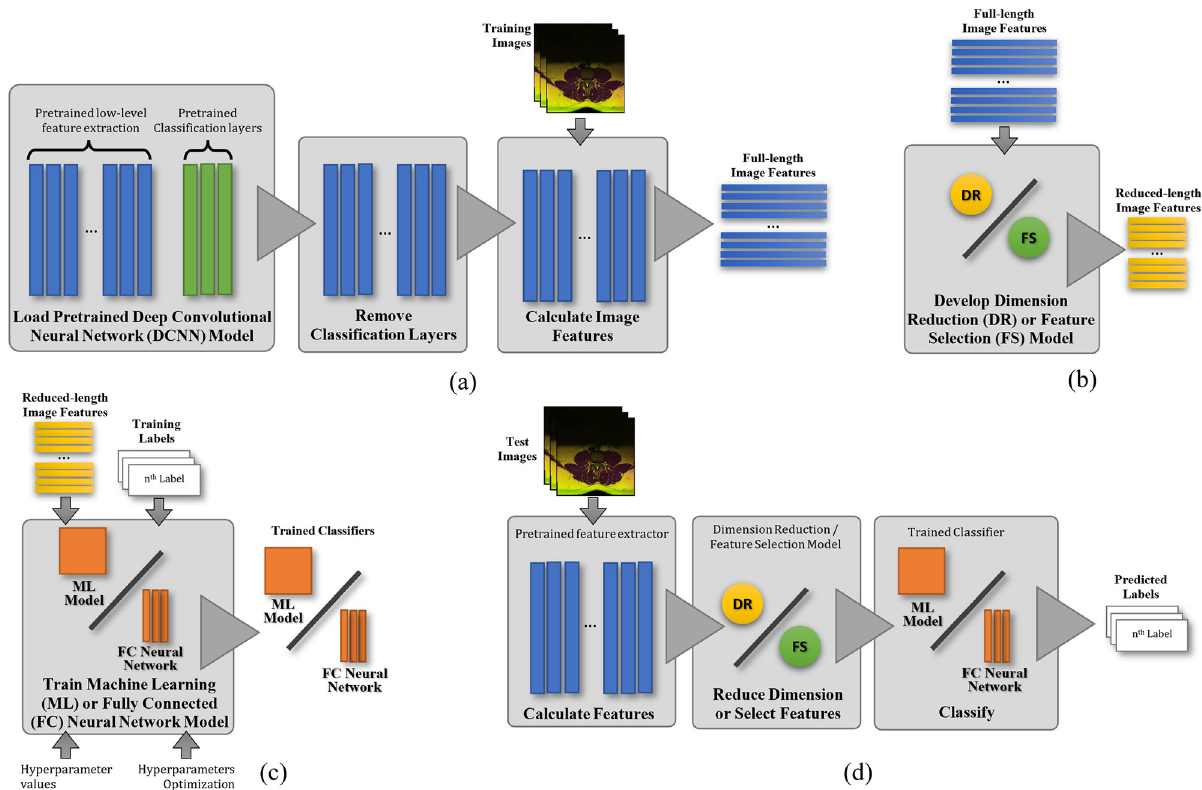
Fig 6. A flowchart describing the methodology used where a) depicts the feature extraction step, b) depicts the DR and FS modeling step, c) depicts the ML and FC training step and d) depicts the inference/classification step.